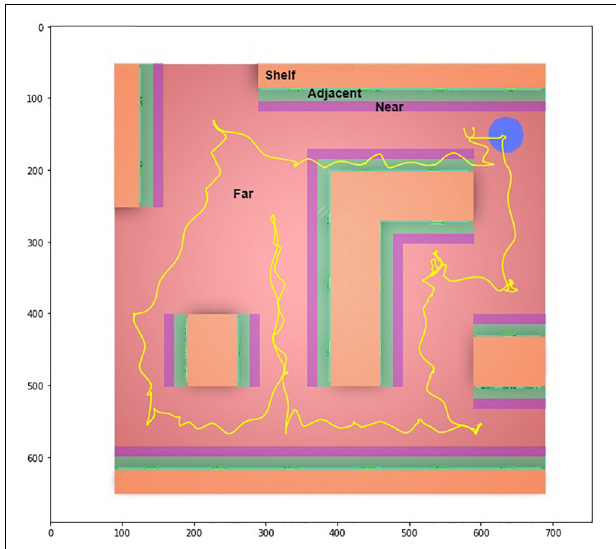
FIGURE 3 | Zenithal view of the virtual hypermarket showing ZOIs and navigation of a participant.